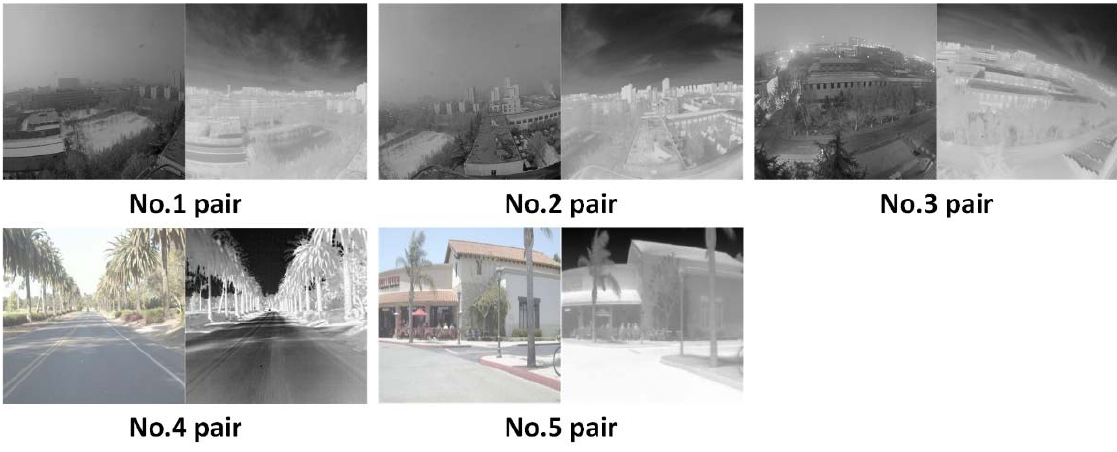
Figure 7. Input image pairs.